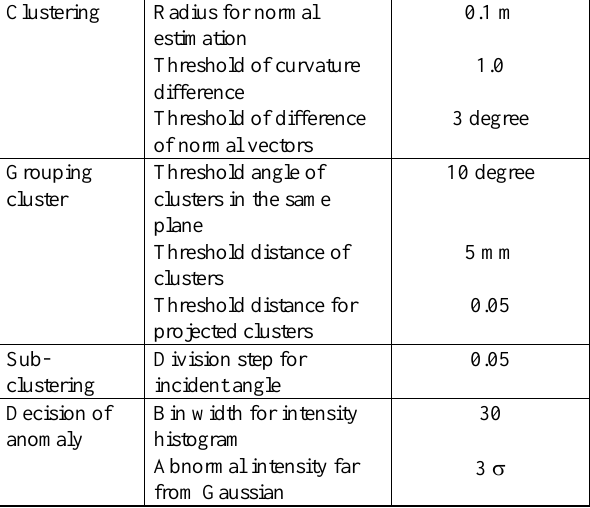
Table 1. Parameters of proposed method.